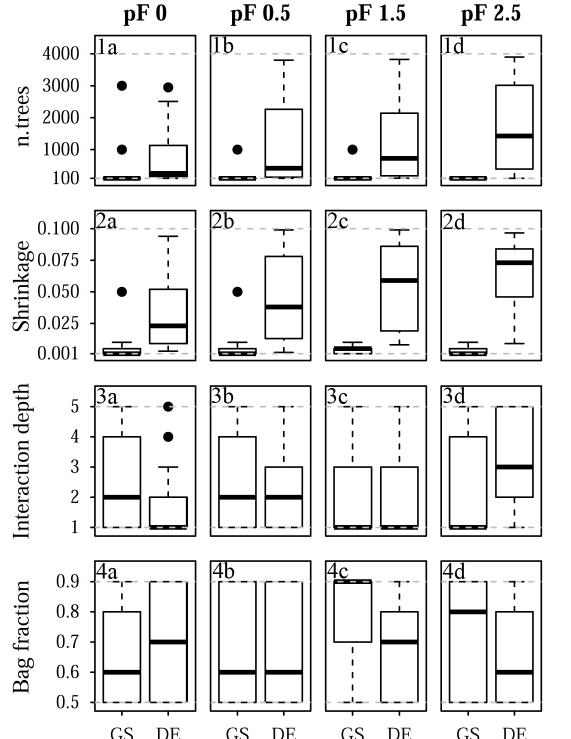
Figure 10. Selected tuning parameter values for Quinuas: (1a–d) n.trees, (2a–d) , shrinkage, (3a–d) interaction depth, and (4a–d) bag fraction for (1a, 2a, 3a, 4a) pF 0, (1b, 2b, 3b, 4b) pF 0.5, (1c, 2c, 3c, 4c) pF 1.5, and (1d, 2d, 3d, 4d) pF 2.5. Each boxplot is based on 25 values corresponding to the five-fold CV with five repetitions. Dashed gray lines indicate the chosen optimization limits. GS refers to grid search, and DE refers to the differential evolution algorithm.